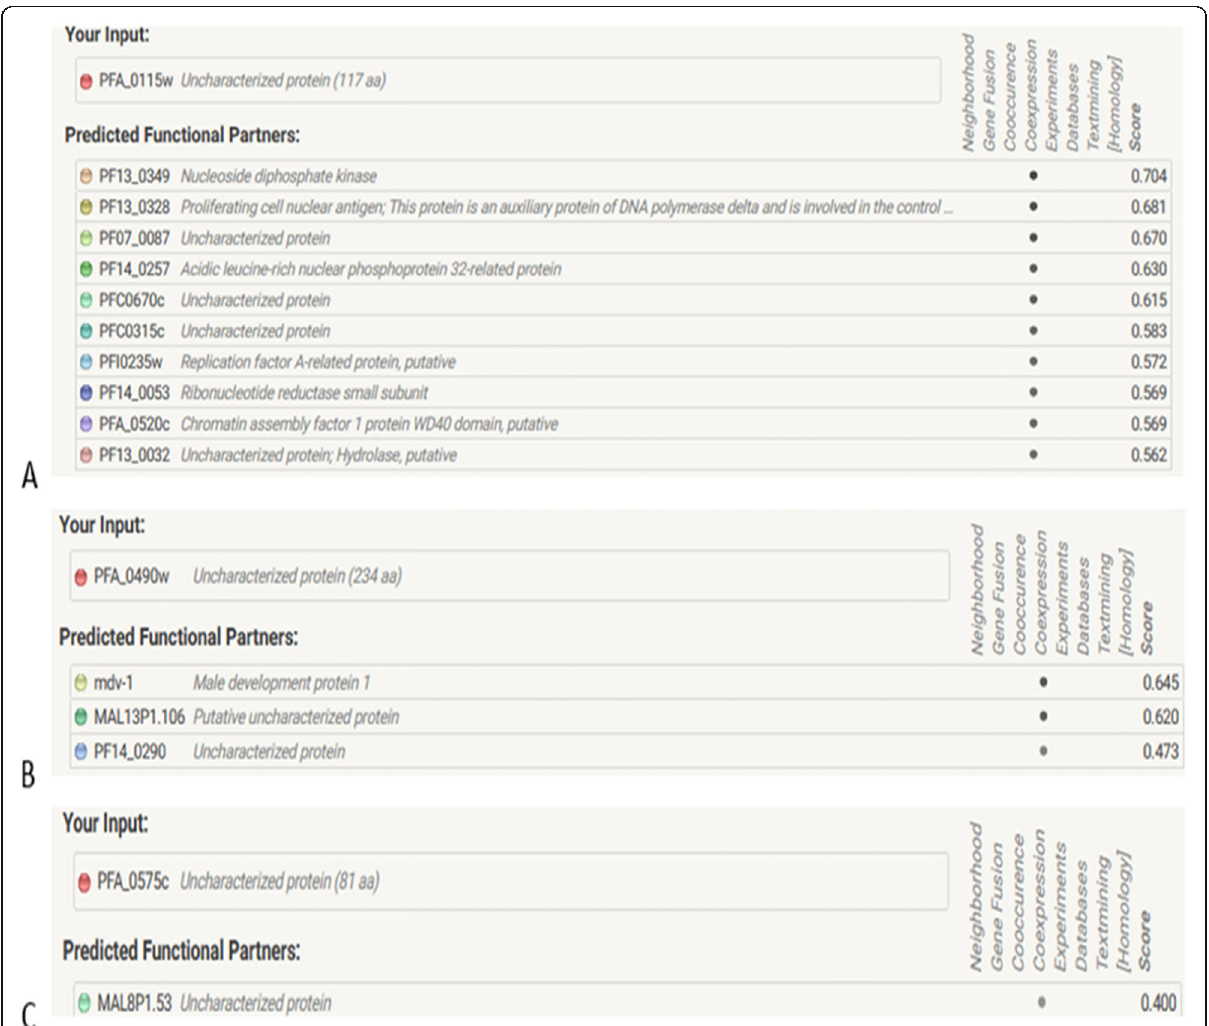
Fig. 3 Screenshots from STRING server of predicted functional partners with query sequences. Top interacting partners have been displayed for